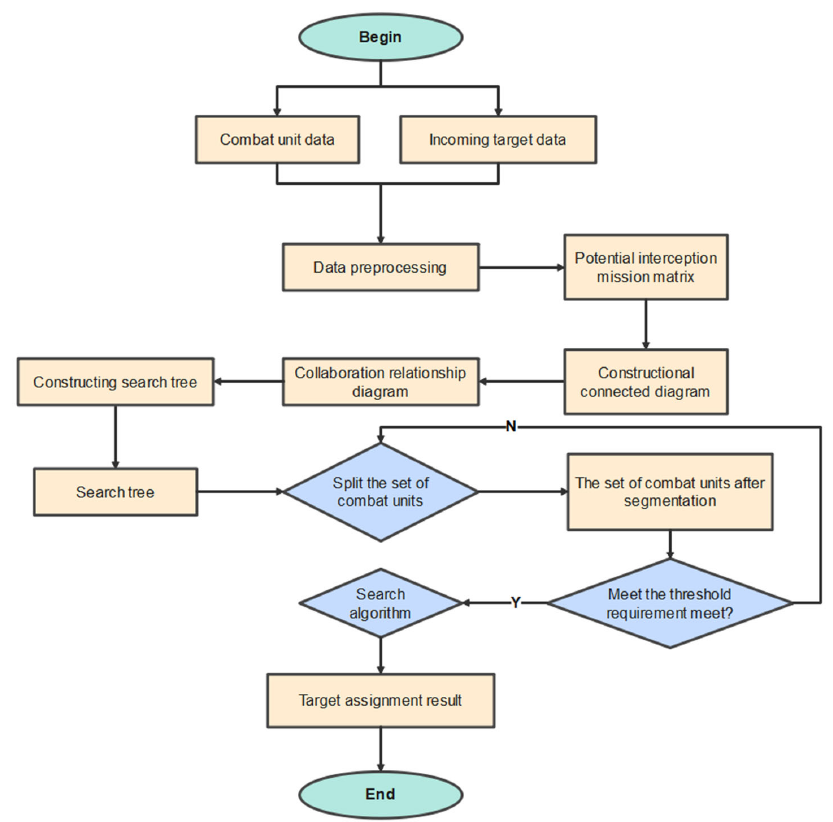
Figure 2. Optimal Figure 2. Optimal structure.